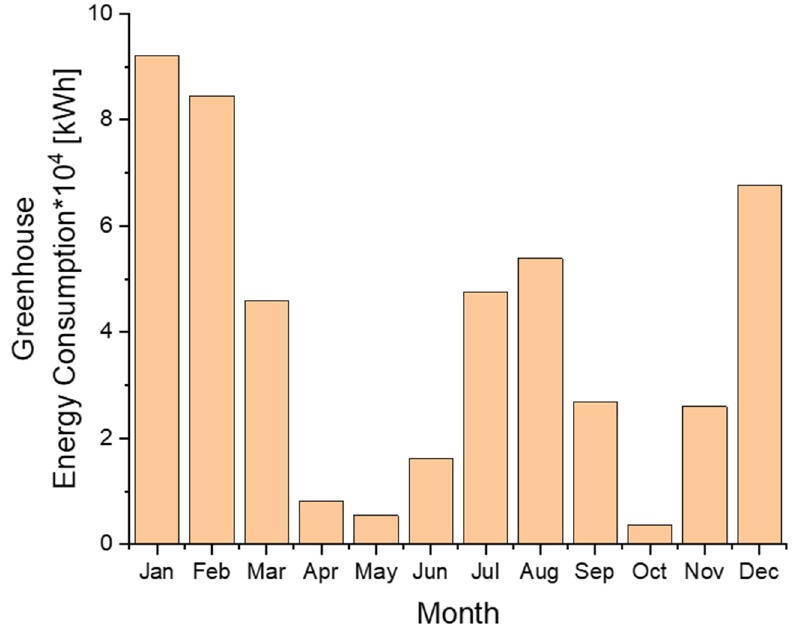
2 greenhouse in